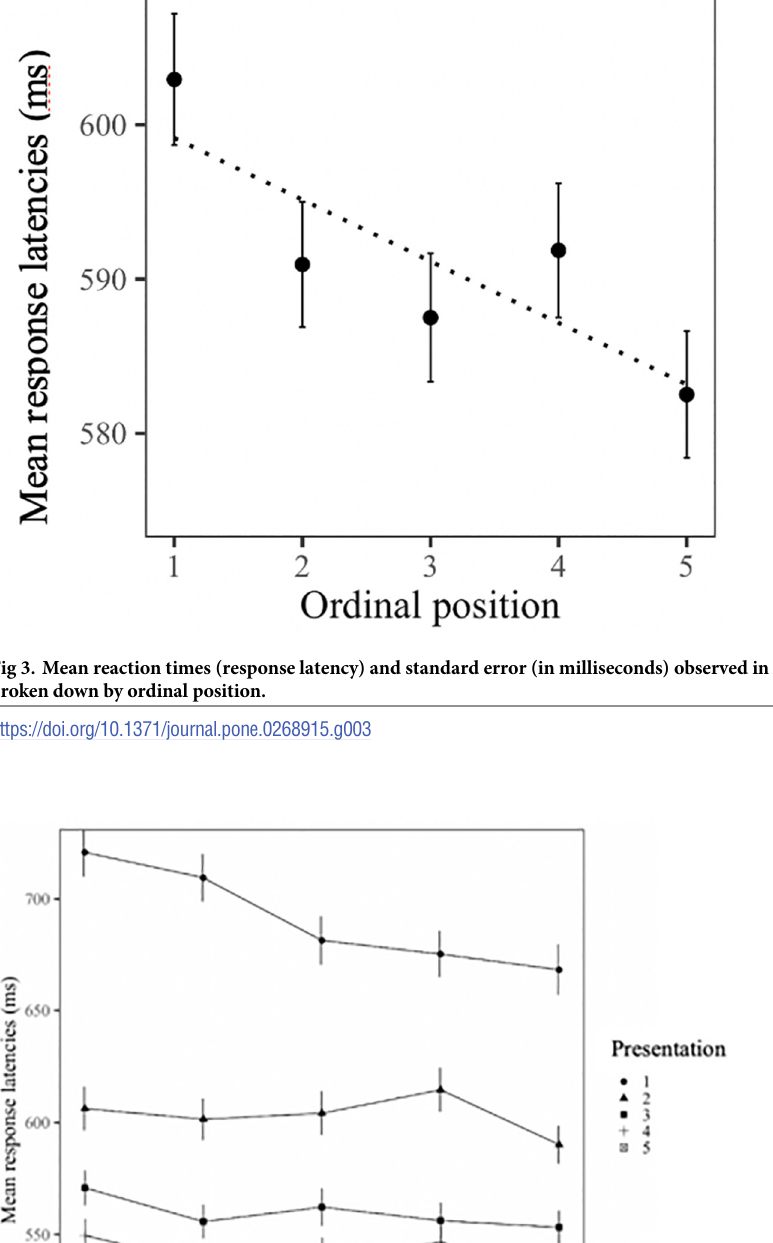
PLOS ONE | https://doi.org/10.1371/journal.pone.0268915 June 9,